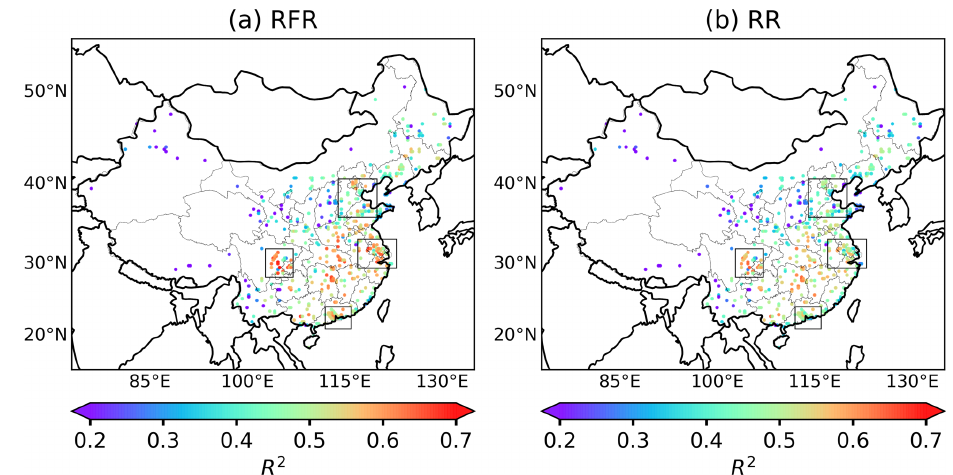
Figure 2. Coefficient of determination ( R 2 ) between deseasonalized observational MDA8 ozone and deseasonalized predicted values in random forest regression (RFR) (a) and ridge regression (RR) (b) . The skill is only measured for the respective test datasets. Each dot represents the centre of the ERA5 grid location, within which station values for MDA8 ozone are averaged.